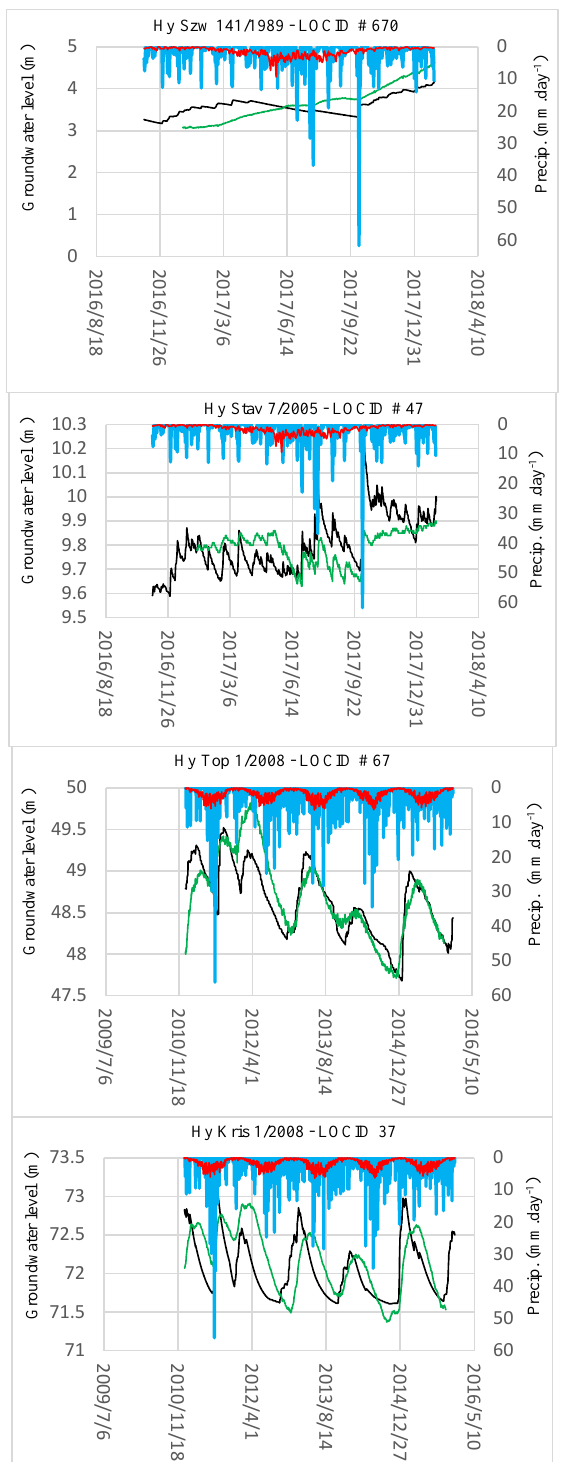
Figure 10. Observed (green) and calibrated (black) groundwater heads in the Tollense River Figure 10. catchment with rainfall (blue) and evapotranspiration (red) rates.